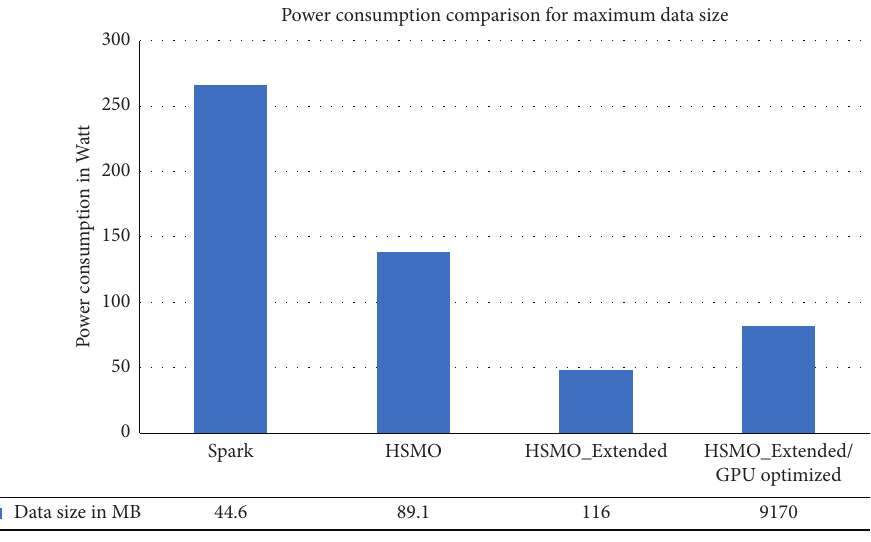
Figure 16: Power consumption comparison for maximum data